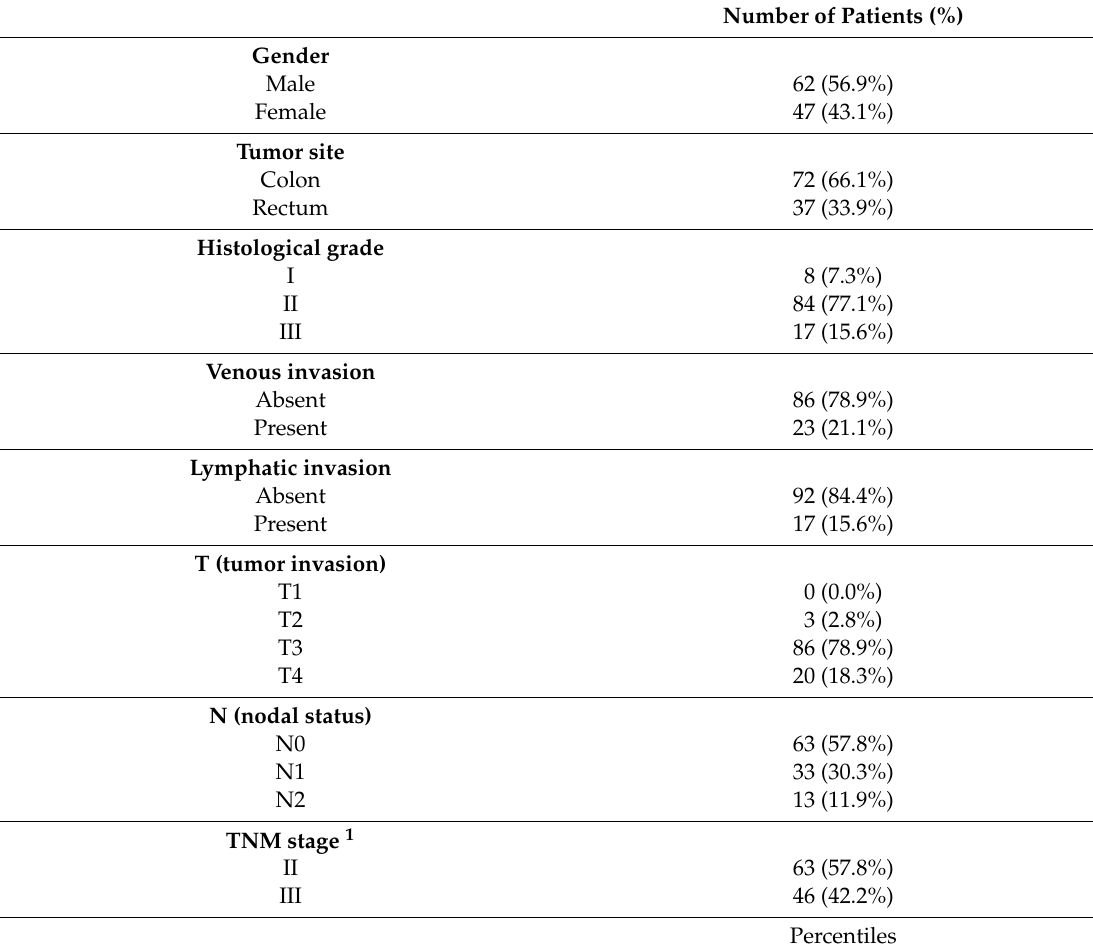
Table 2. Characterization of the 109 colorectal cancer (CRC) cases and expression of DDC novel exons in cancerous and non-cancerous colorectal tissue